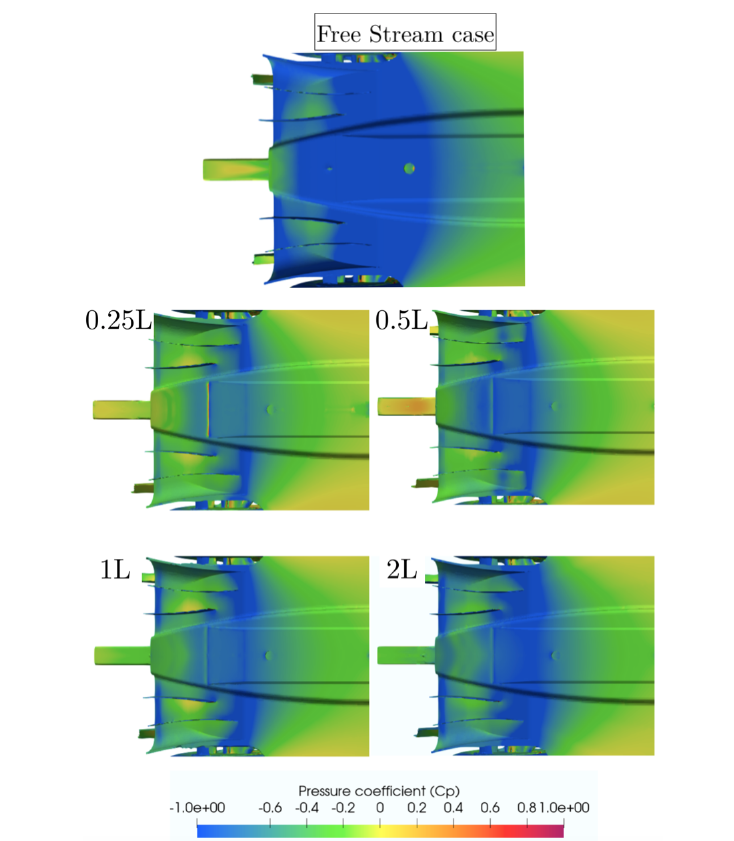
Figure 21. Pressure coefficient distribution on the diffuser of the second car at a distance of 0.25 L, 0.5 L, 1 L, and 2 L as compared to the free stream case.